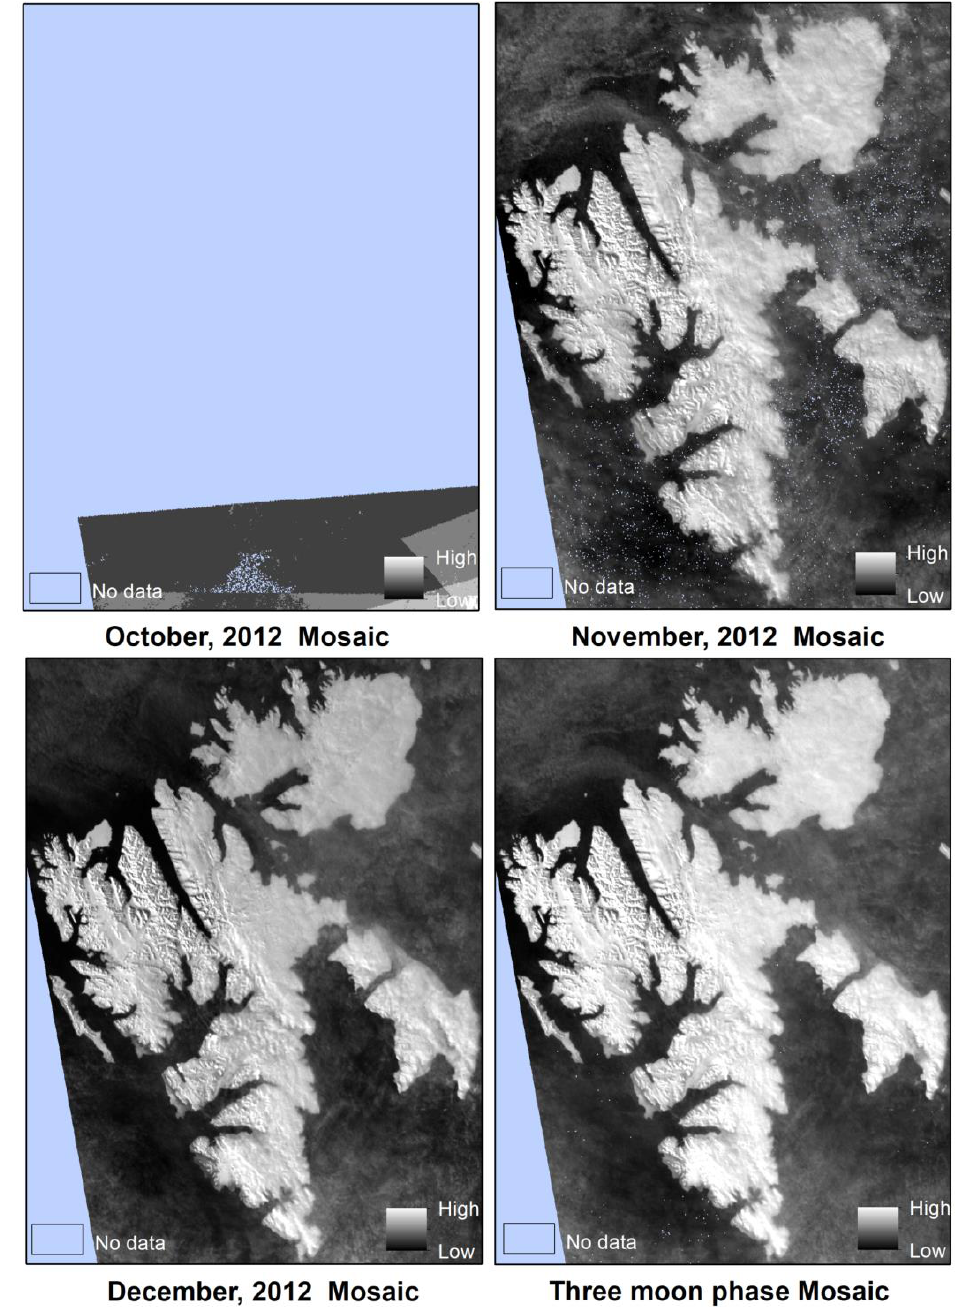
Figure 7. Every one-moon-phase mosaic image (October–December 2012) and three-moon-phase mosaic.